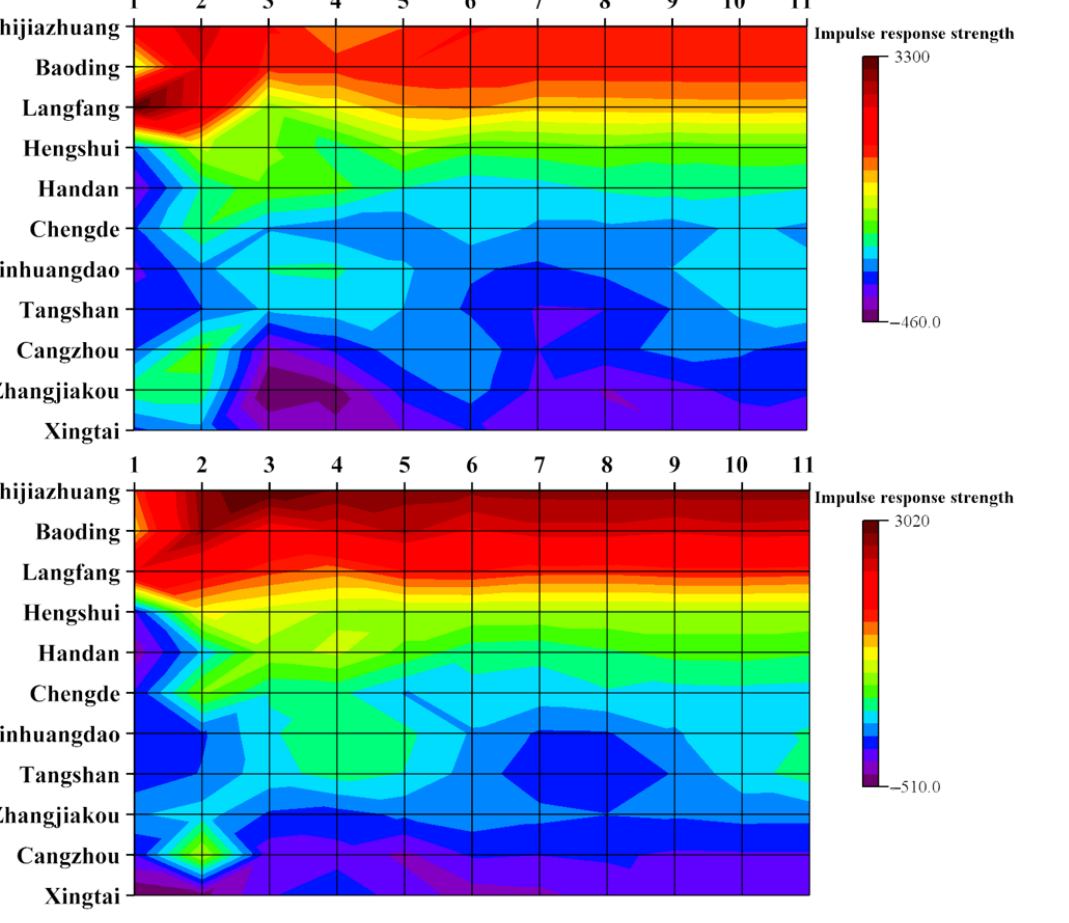
Figure 10. Impulse response results of responding cities caused by a unit impact on Beijing ( top ) and Tianjin ( bottom ) housing prices in the BTHUA.